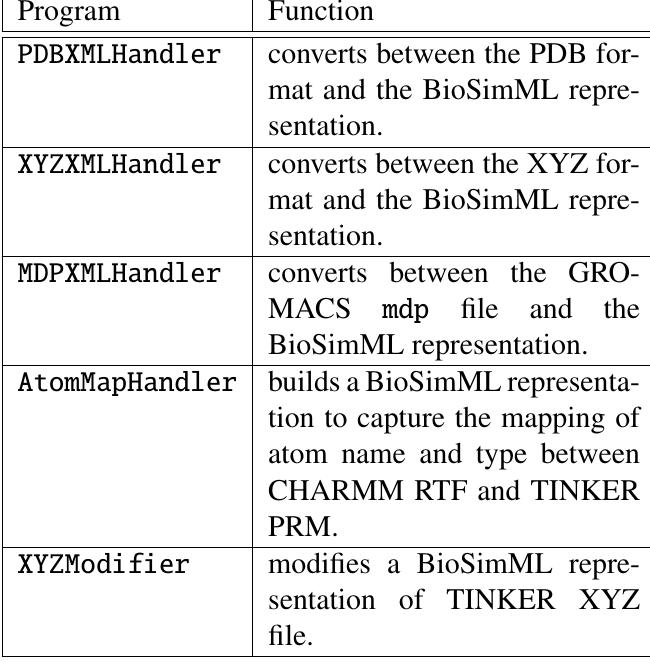
Table 1: The programs of the BioSimML toolkit